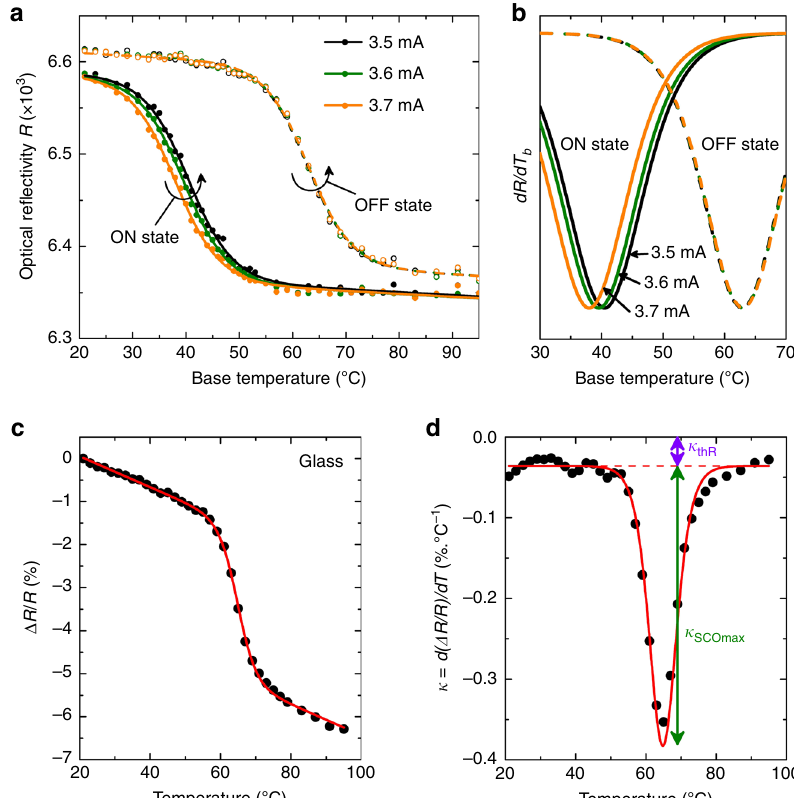
Fig. 5 Temperature resolution and sensitivity. a ON-state and OFF-state thermal transition curves recorded by optical re fl ectivity in a 1- µ m-wide area of the SCO-coated glass substrate for three close values of the applied electrical current ( I = 3.5, 3.6, and 3.7 mA). b Fitted derivative curves (d R /d T b vs. T b ) showing a measurable temperature shift for the ON-states. These measurements demonstrate that surface temperature variations as small as 1 °C can be unambiguously determined. c Typical thermal evolution of Δ R / R ( λ = 452 nm) measured on a glass substrate coated with a 200-nm-thick fi lm of 1 . d Thermal evolution of the corresponding thermore fl ectance coef fi cient de fi ned as κ = d( Δ R / R )/d T . At the spin-transition temperature, the thermal sensitivity is found one order of magnitude larger compared to the ordinary thermore fl ectance. Red solid lines correspond to the best fi t to the data using a sigmoidal